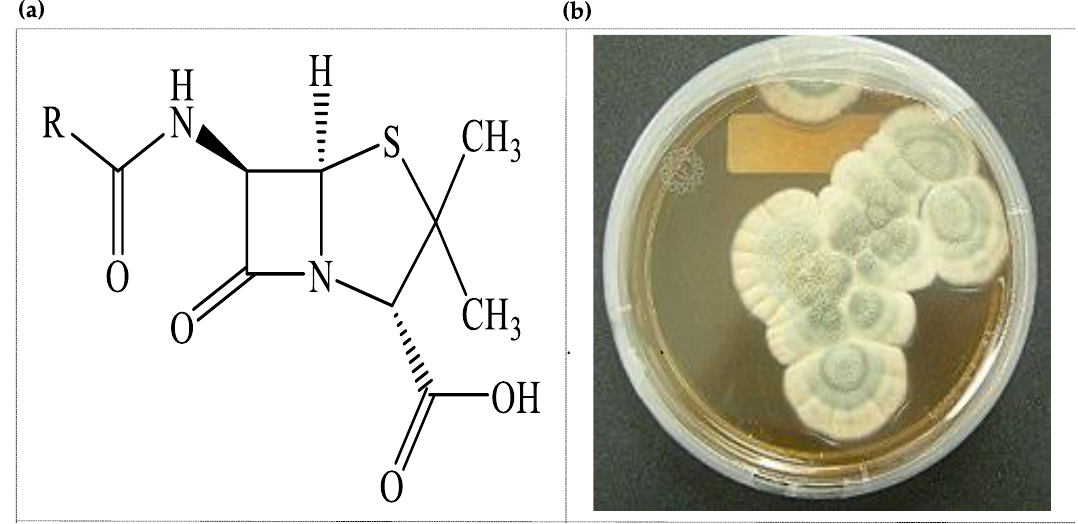
Figure 1. ( a ) Core structure of penicillin, the first antibiotic from fungus; ( b ) Penicillium notatum.